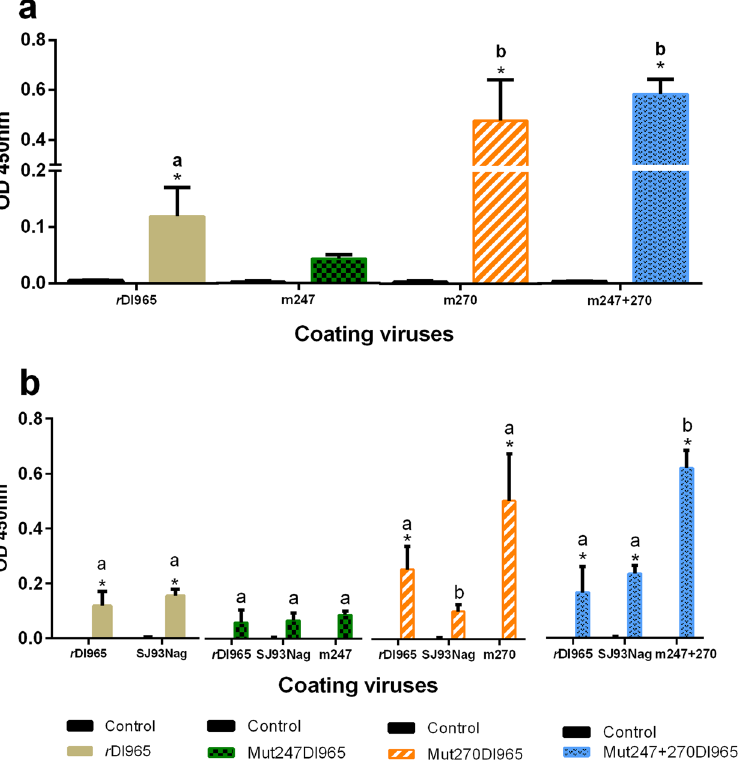
Figure 5. Serological study of sea bass infected with recombinant viruses. ( a ) Level of anti-betanodavirus antibodies evaluated by indirect ELISA. Different letters denote significant differences among infected groups (p < 0.05). ( b ) Cross-reaction between antibodies in sera from European sea bass inoculated with r Dl965, Mut247Dl965, Mut270Dl965 or Mut247 + 270Dl965, and different viral antigens (lysates of E-11 cells inoculated with the different viruses considered). Different letters denote significant differences among different coating viruses within each experimental group (p < 0.05). Data were statistically analysed with the one-way ANOVA test. Asterisk indicates significant differences (p < 0.05) between control (sera from L-15-injected fish) and infected groups. Results are mean ± s.d. of three samples composed of sera from five fish. All sera were analysed at 1/64